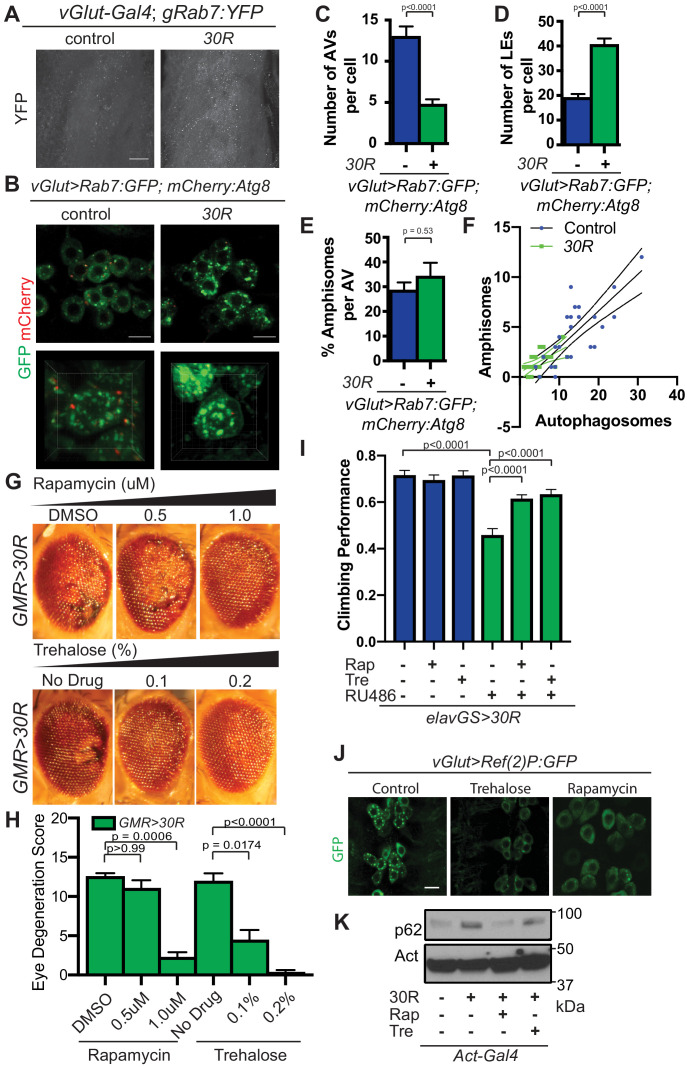
Rescuing G4C2-mediated lysosome defects reduces neurodegeneration.(A) vGlut/+ or vGlut >30R with genomically tagged Rab7:YFP (gRab7:YFP) in the L3 larval ventral nerve cord (VNC). Scale bar = 10 µm (B) Control vGlut motor neurons co-expressing Rab7:GFP and -mCherry:Atg8 in the VNC (top) or a representative single cell (bottom). Scale bar = 10 µm (C) Quantification of number of Atg8 positive autophagic vesicles (AV) per cell. Data are presented as mean ± SEM. Mann-Whitney test, n = 29 and 24 cells, respectively. (D) Quantification of number of Rab7 positive late endo/lysosomes (LE) per cell. Data are presented as mean ± SEM. Mann-Whitney test, n = 29 and 24 cells, respectively. (E) Number of amphisomes (co-localized mCherry:Atg8 and Rab7:GFP puncta) per cell normalized to the total number of autophagosomes. Data are presented as mean ± SEM. Mann-Whitney test, n = 29 and 24 cells respectively. (F) Number of amphisomes (co-localized mCherry:Atg8 and Rab7:GFP puncta) plotted against number of autophagic vesicles for vGlut/+ control and vGlut >30R motor neurons. Curves represent simple linear regression for each genotype. (G) Eyes from15-day-old Drosophila expressing UAS-30R under the control of GMR-Gal4 fed with increasing concentrations of rapamycin (DMSO, 0.5 µM, or 1 µM) and trehalose (no drug, 0.1%, or 0.2%). (H) Quantification of eye degeneration in G. Data are presented as mean ± SEM. Kruskal-Wallis test, p<0.0001, followed by Dunn’s multiple comparisons, n = 10 per genotype. (I) Adult Drosophila expressing UAS-30R under the control of the inducible, pan-neuronal elavGS driver induced with 200 µM RU486 have decreased climbing ability at 7 days compared to non-induced controls, which is rescued by supplementing food with rapamycin or trehalose. One-way ANOVA, p<0.0001, with Sidak’s multiple comparisons test, n = 10 groups of 10 flies per genotype. (J) Drosophila motor neurons expressing UAS-p62:GFP and UAS-30R from 3rd instar larvae fed DMSO (control), 1.0 µM rapamycin, or 0.2% trehalose. (K) Western of lysates from whole Drosophila larvae expressing no repeats or UAS-30R driven by Act-Gal4 and fed DMSO, 1.0 µM rapamycin, or 0.2% trehalose and blotted for p62.